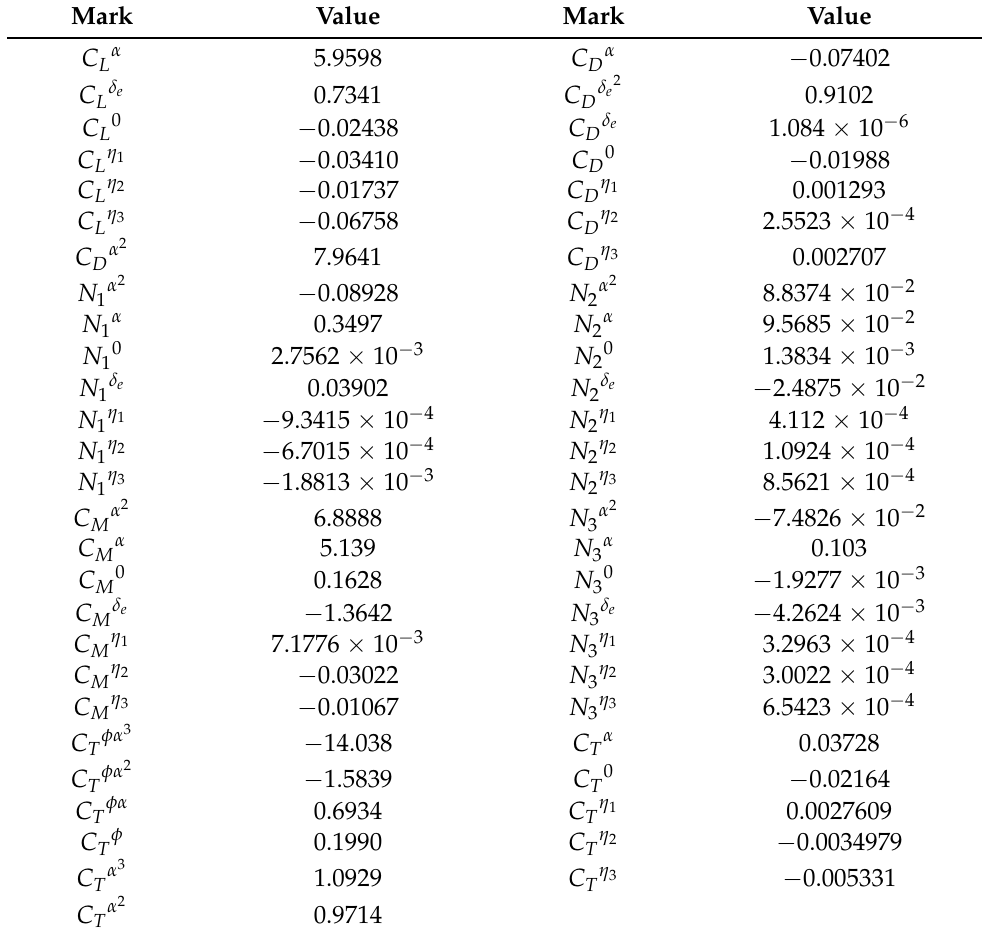
Table 2. Aerodynamic